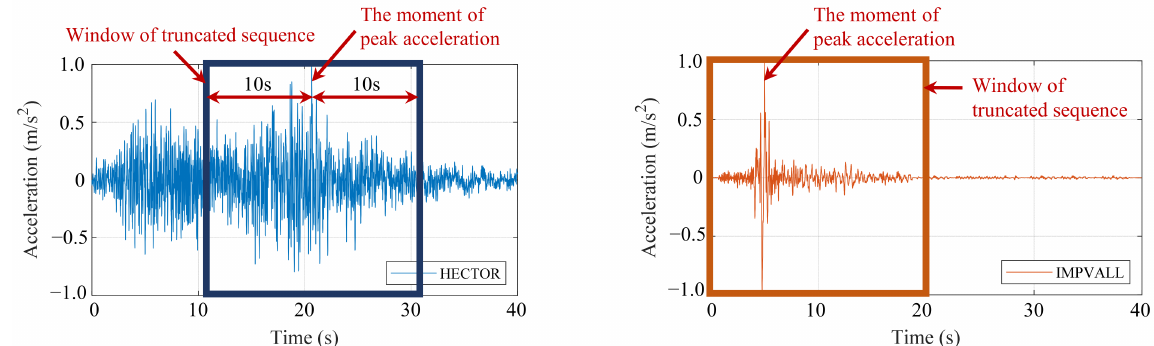
Figure 5. Schematic diagram of ground motion truncation.